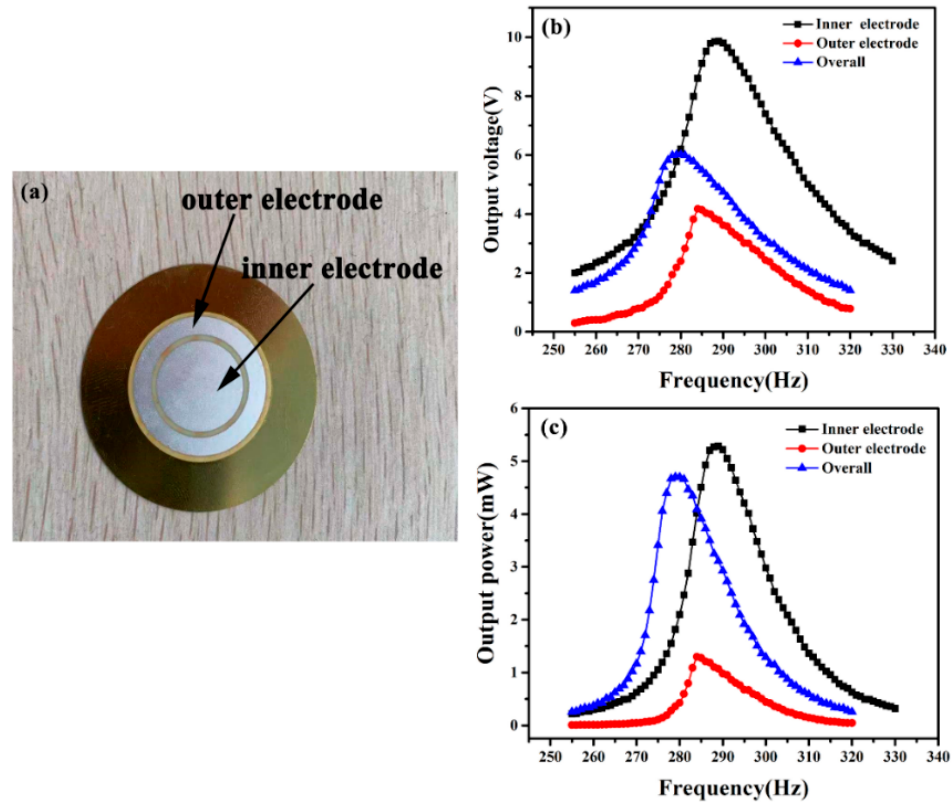
Figure 4. Schematic diagram ( a ), output voltage ( b ), and output power ( c ) of the inner and outer electrodes.